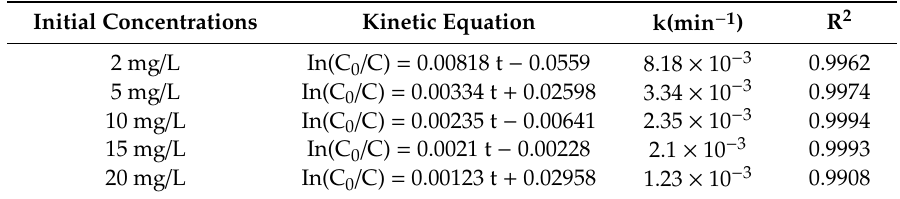
Table 2. Reaction kinetics parameters of photocatalytic of MB with di ff erent initial concentrations using the SBC-TiO 2 carrier.